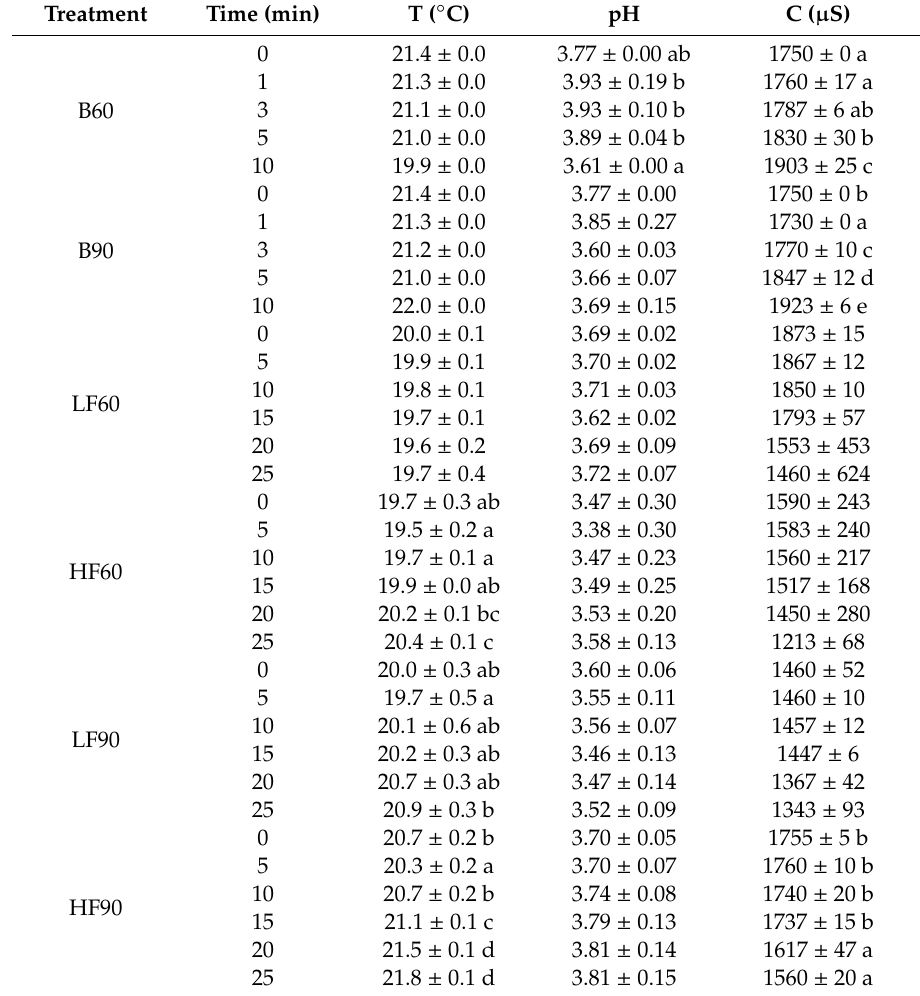
Table 2. Average physical parameters assessed for wine with di ff erent Argon APCP treatments and the standard deviation of data ( n =